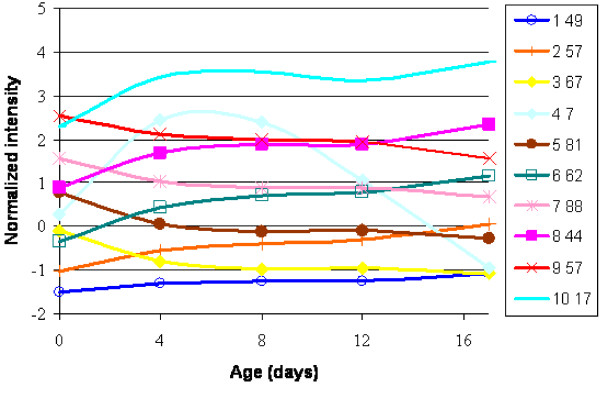
Expected cDNA expression trajectories for each of the 10 groups identified in the ligustica (L) data set. The legend indicates the group number and the estimated number of cDNAs per group.